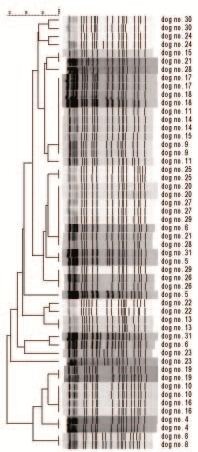
Dendogram of the 26 pairs of isolates from 26 dogs compared by pulsed-field gel electrophoresis.